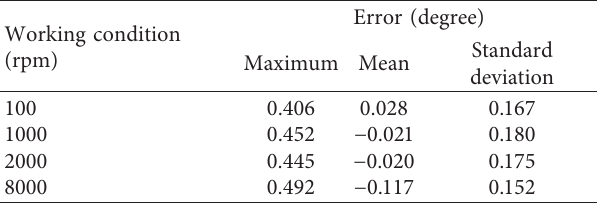
Figure 8: Simulation results under various working conditions. (a) Demodulation signals. (b) Rotor angle. (c) Angle error. Table 1: Angle error statistics under various working conditions.